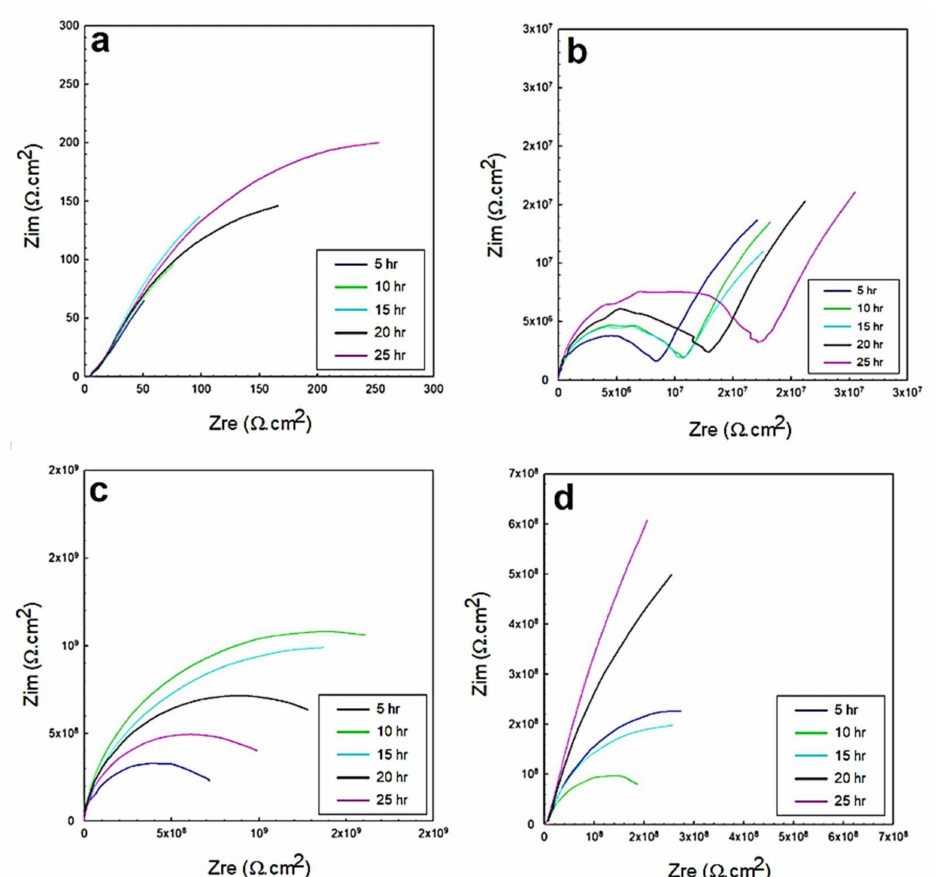
Figure 8. EIS Nyquist plots of the 0.5 M NaCl solution for: ( a ) exposed steel, ( b ) glass/epoxy, ( c ) Kevlar/epoxy, and ( d ) epoxy systems.